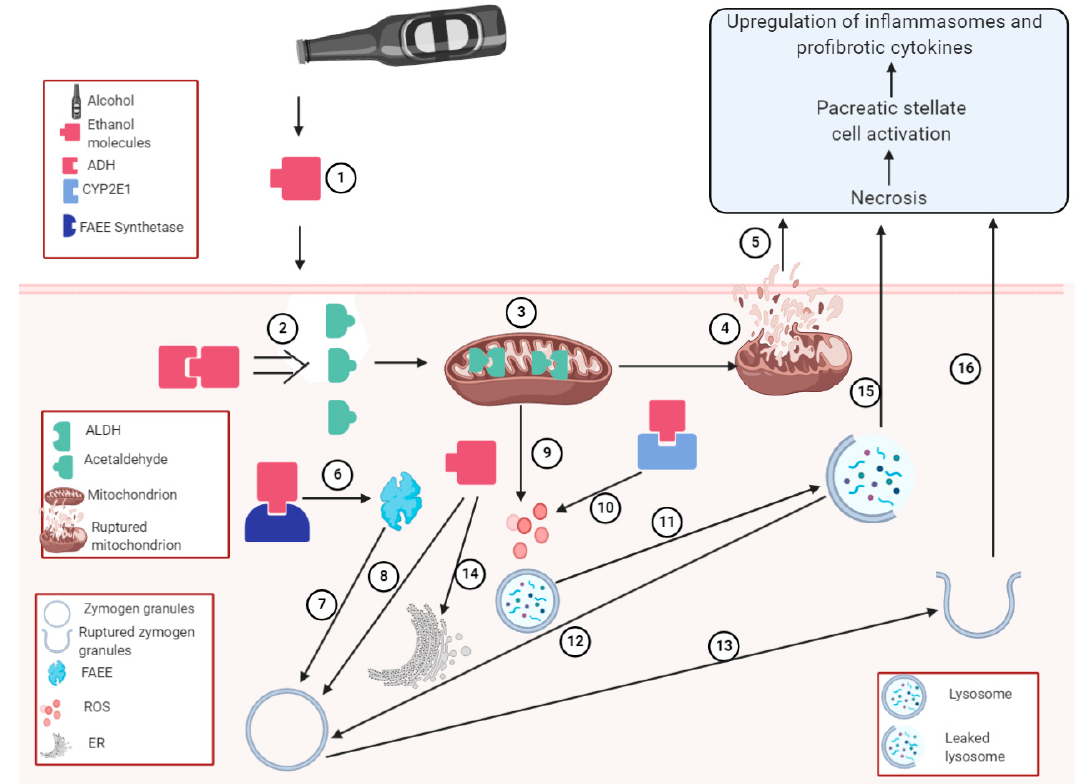
Figure 2. Alcoholic pancreatitis: Visual depiction of the mechanisms of alcohol-induced pancreatitis: We observed that the mechanisms of alcohol-induced pancreatitis include:(1) Exposure of cell to alcohol molecules; (2) oxidative metabolism of alcohol in the presence of alcohol dehydrogenase (ADH) to yield reactive toxic metabolite, acetaldehyde; (3) detoxification of acetaldehyde in the mitochondrion by aldehyde dehydrogenase (ALDH); (4) Oxidative stress-triggered mitochondrion membrane rupture; (5) Mitochondrion membrane rupture leading to necrosis; (6) Alcohol undergoing nonoxidative metabolism to form fatty acid ethyl esters (FAEE); (7) FAEE weakening zymogen granule membranes; (8) unmetabolized alcohol directly weakening zymogen granule membranes; (9) mitochondrion releasing ROS; (10) ethanol metabolism by CYP2E1 releasing ROS; (11) ROS rupturing lysosome membrane; (12) released lysosome hydrolases from ruptured lysosome weakening the zymogen granule membranes; (13) Zymogen granule membrane rupture and activation; (14) Ethanol upregulating UPR with no ER stress observed; (15) Ruptured lysosomes inducing necrosis; (16) Ruptured zymogen granules inducing necrosis.